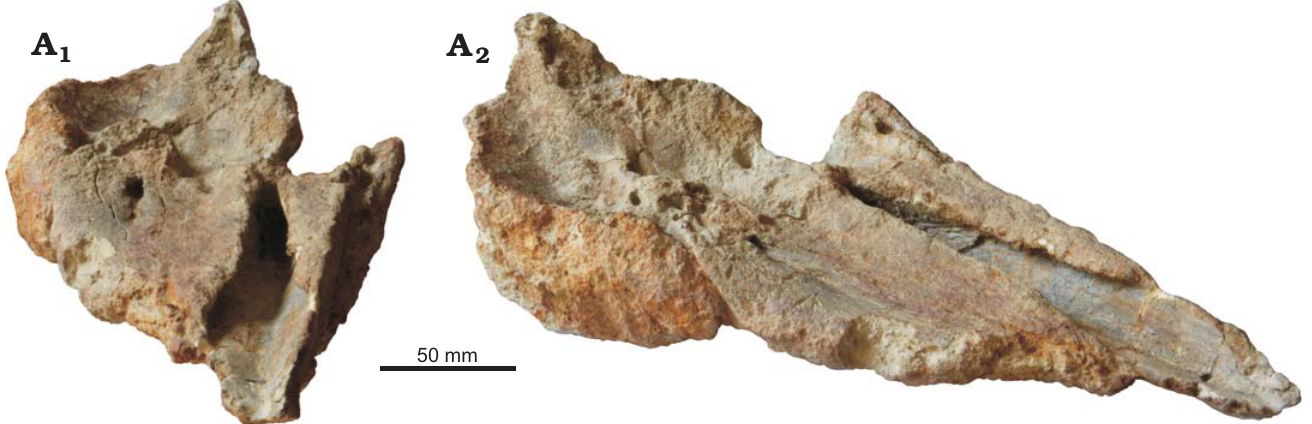
Fig. 4. Cranium, in lateral view, of the kogiid sperm whale Pliokogia apenninica gen. et sp. nov. (MSNUP I-17603, holotype), from the lower Pliocene of Sant’Andrea Bagni (Northern Apennines, northern Italy). Photograph (A 1 ), explanatory drawing (A 2 ). The grey vertical stripes denote abraded or broken areas. Dashed line for approximating the position of the frontal-lacrimojugal complex suture.